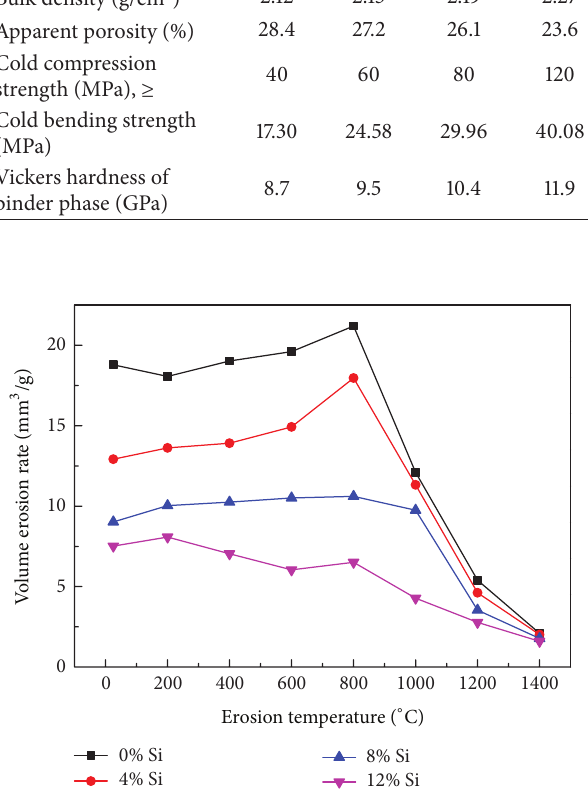
Figure 3: The volume erosion rates of the samples with respect to the test temperature and silicon powder